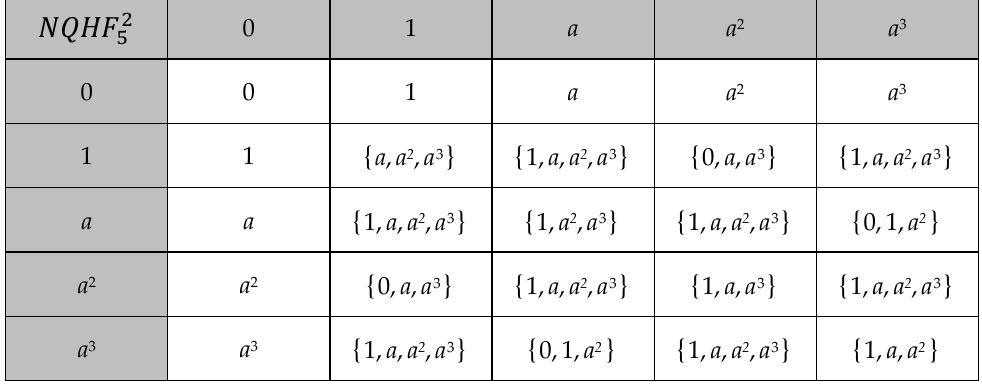
Table 24. The Cayley table of the additive canonical hypergroup of the second non-quotient hyperfield.